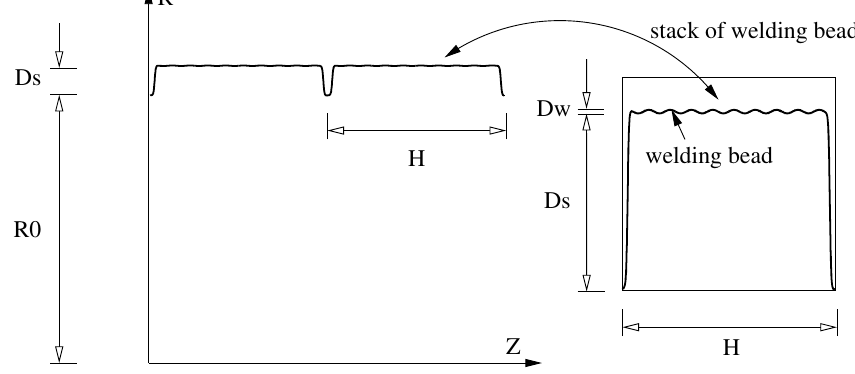
Figure 6. Geometrical quantities of verification example for rough